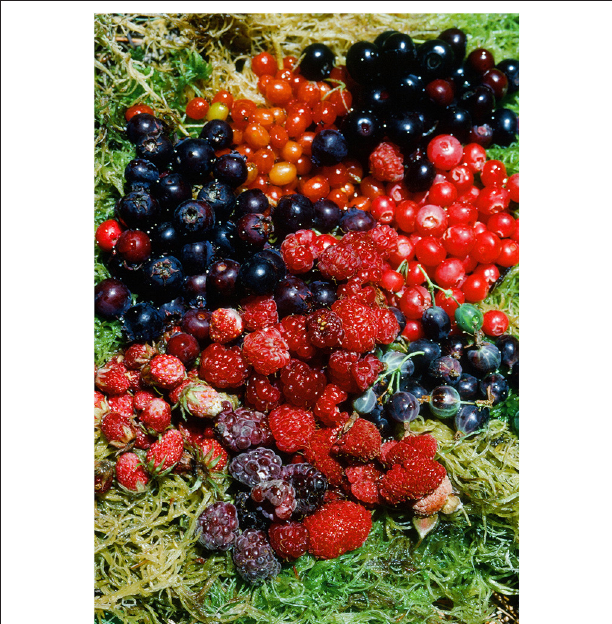
FIGURE 5 | Berries harvested in mid-July, Nuxalk